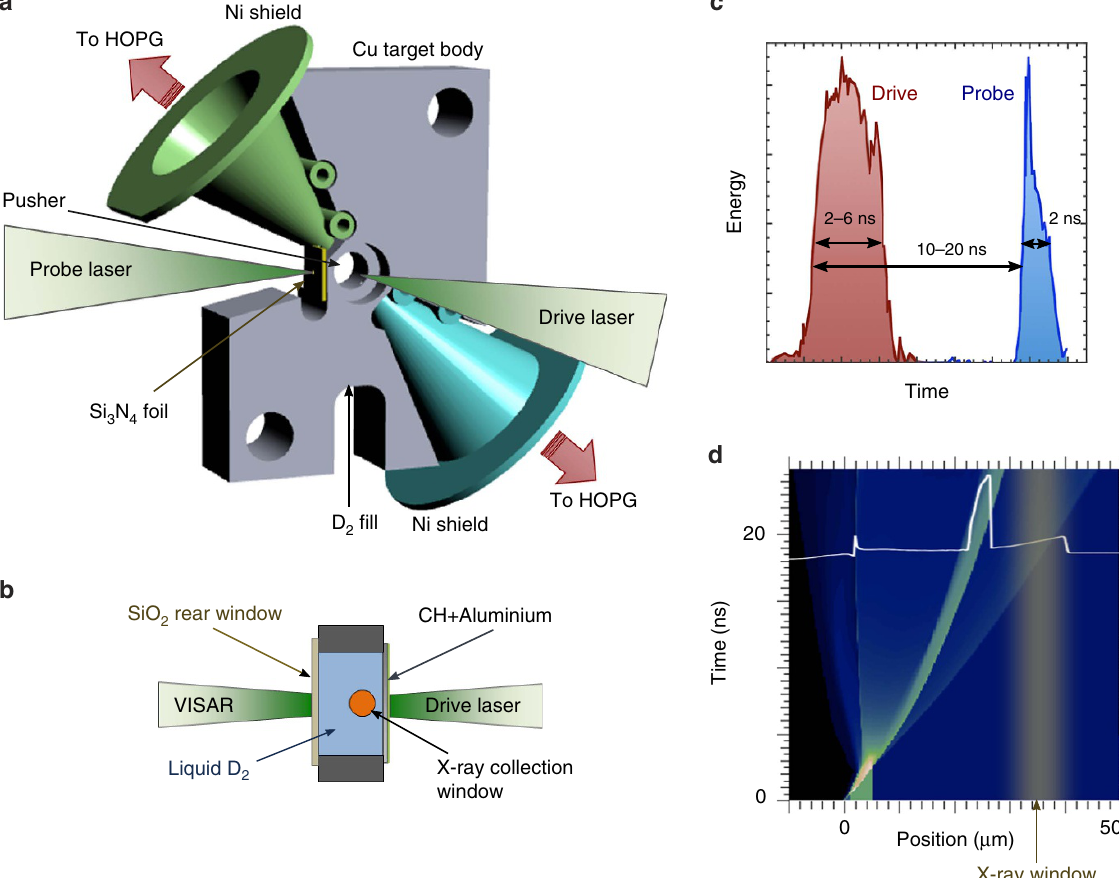
Figure 2 | Experimental set-up and timing. ( a ) The copper target is held at 19K, liquefying the deuterium that is filled into the central cavity. A drive laser is incident on a 2-mm-diameter Al pusher, launching a shock wave along the axis. A probe laser irradiates a Si 3 N 4 foil, pumping the 2,005eV Si Ly- a transition. X-rays scattered in the forward and backward directions are spectrally dispersed with highly oriented pyrolytic graphite (HOPG) crystals whose direct view of the laser-plasma is prevented by Ni shields. ( b ) Cross section of the target reservoir across the thickness of the target. The target is sealed with aluminium on the front surface and a transparent quartz rear window to allow the VISAR beam to probe shock evolution. ( c ) Schematic of laser beam timing showing the shock drive beam (red) of 2–6ns preceding a 2-ns probe pulse. The probe is delayed by 10–20ns, depending on drive intensity, to allow the shock front to advance into the x-ray spectrometer view. Shorter delay times yielded higher shock pressures. ( d ) HYDRA simulations of mass density evolving as a function of space and time, with a lineout at the x-ray probe time of 20ns. The compressed D 2 peak ( r Shock ¼ 0.54gcm (cid:2) 3 ) has traversed into the spectrometer field of view at t ¼ 20ns when we make the x-ray measurement. The high-density peak lagging the D 2 shock front is due to the aluminium pusher, but is shielded by the x-ray